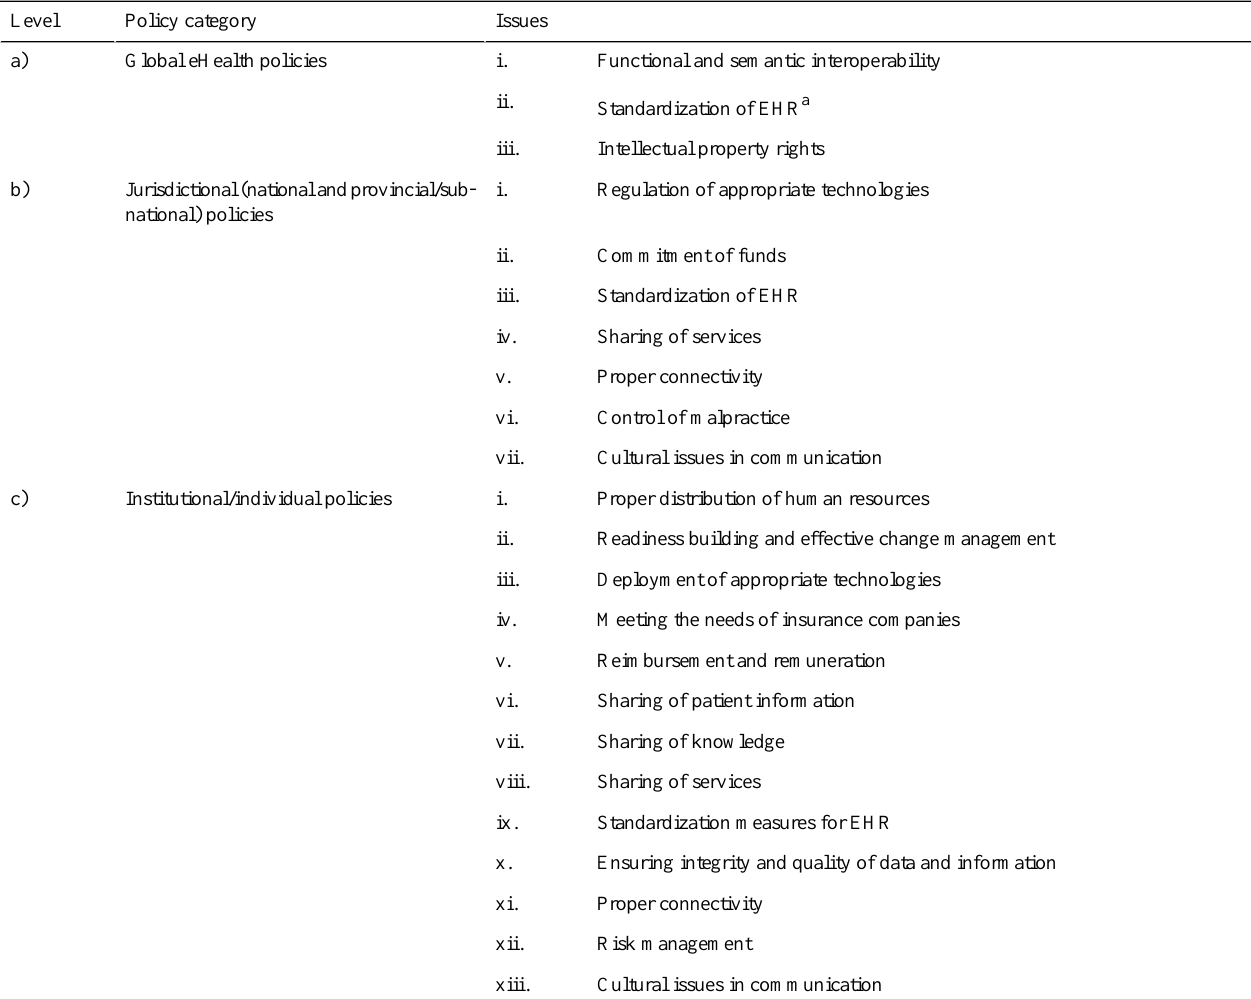
Table 1. Networked